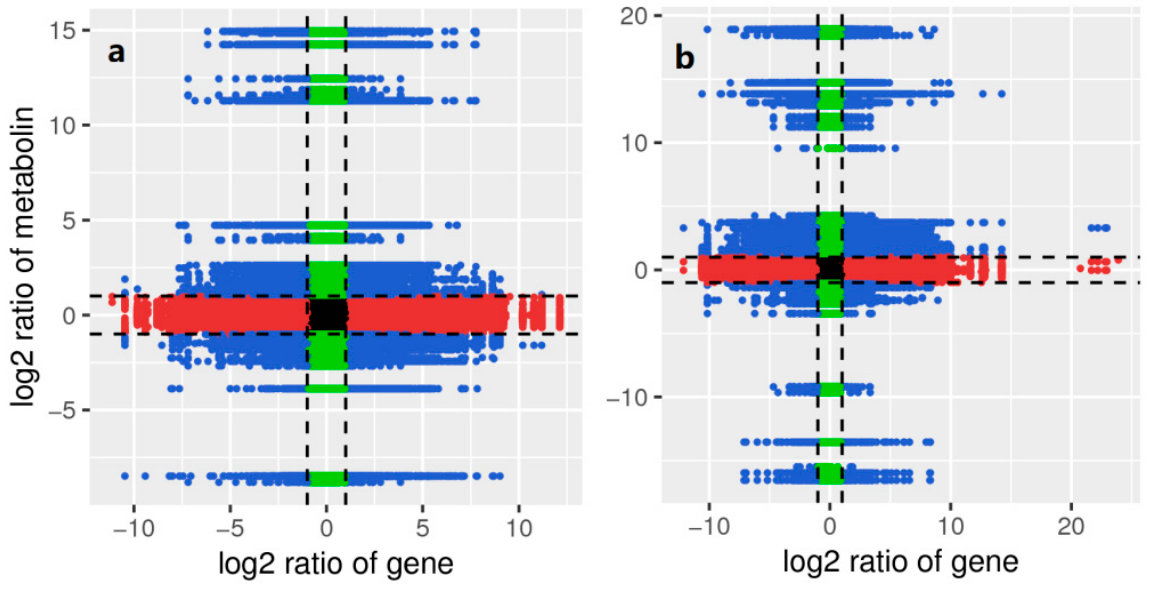
Figure 7. Correlation between different metabolites and genes in flower bud in pre ‐ and post ‐ winter. With the black dotted line as the boundary, it is divided into 1 – 9 quadrants from left to right and from top to bottom, Quadrants 3 and 7 represent positive correlation between genes and metabolites. The change of metabolites may be positively regulated by genes, and the differential expression pattern of genes and metabolites is consistent. Blue represents differential metabolites and expressed genes, green represents non differential metabolites, and red represents non differential expressed genes . ( a ) The CMF in pre ‐ and post ‐ winter; ( b ) the IMF in pre ‐ and post ‐ winter.